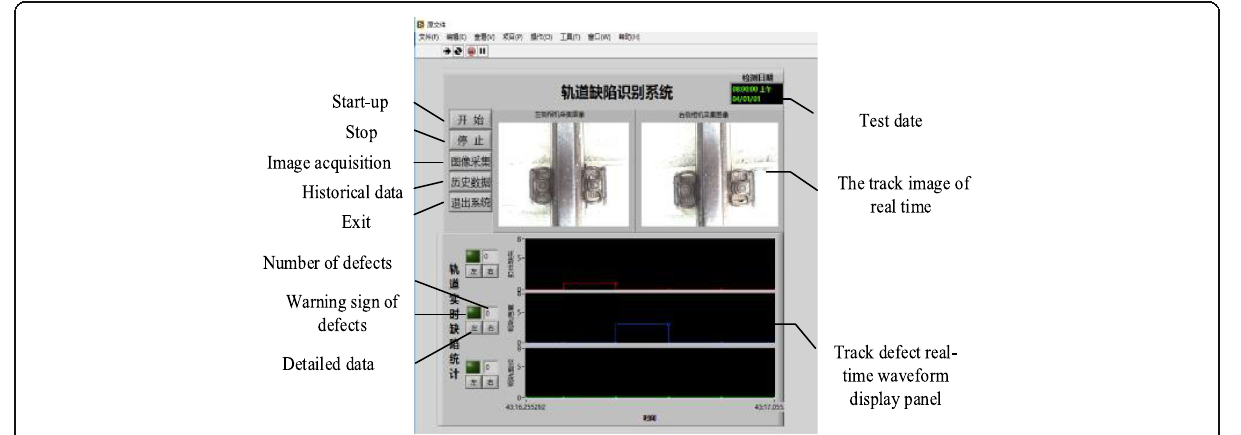
Fig. 12 Surface defect visual inspection system